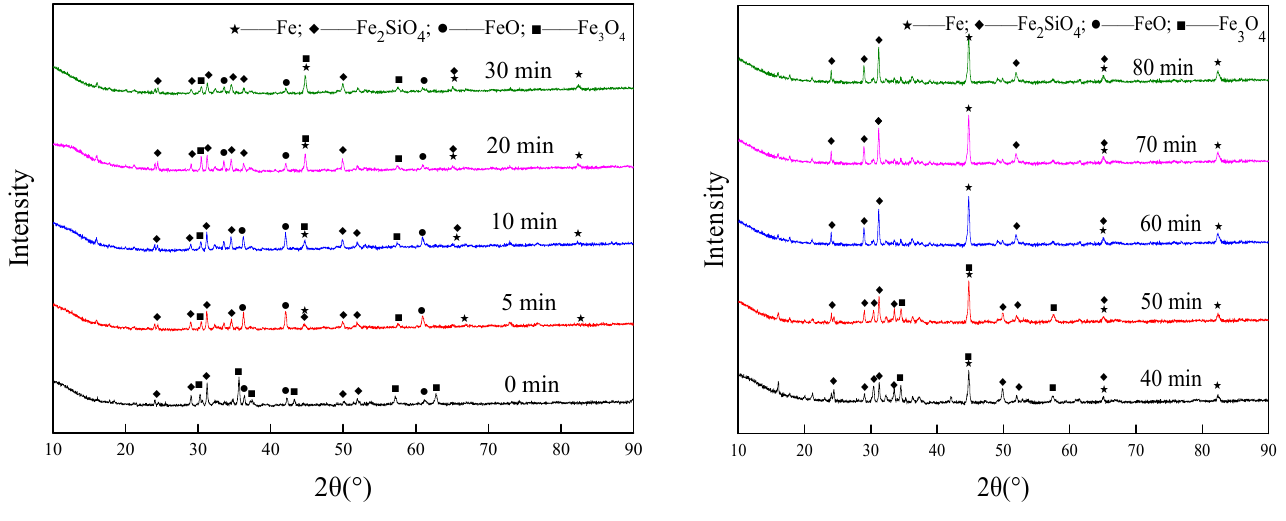
Figure 5. XRD patterns of copper slag after reduction. Table 2. The chemical composition of copper slag after reduction under suitable conditions (wt. %). T Fe M Fe FeO Cu Pb S C Zn 42.51 36.15 <0.004